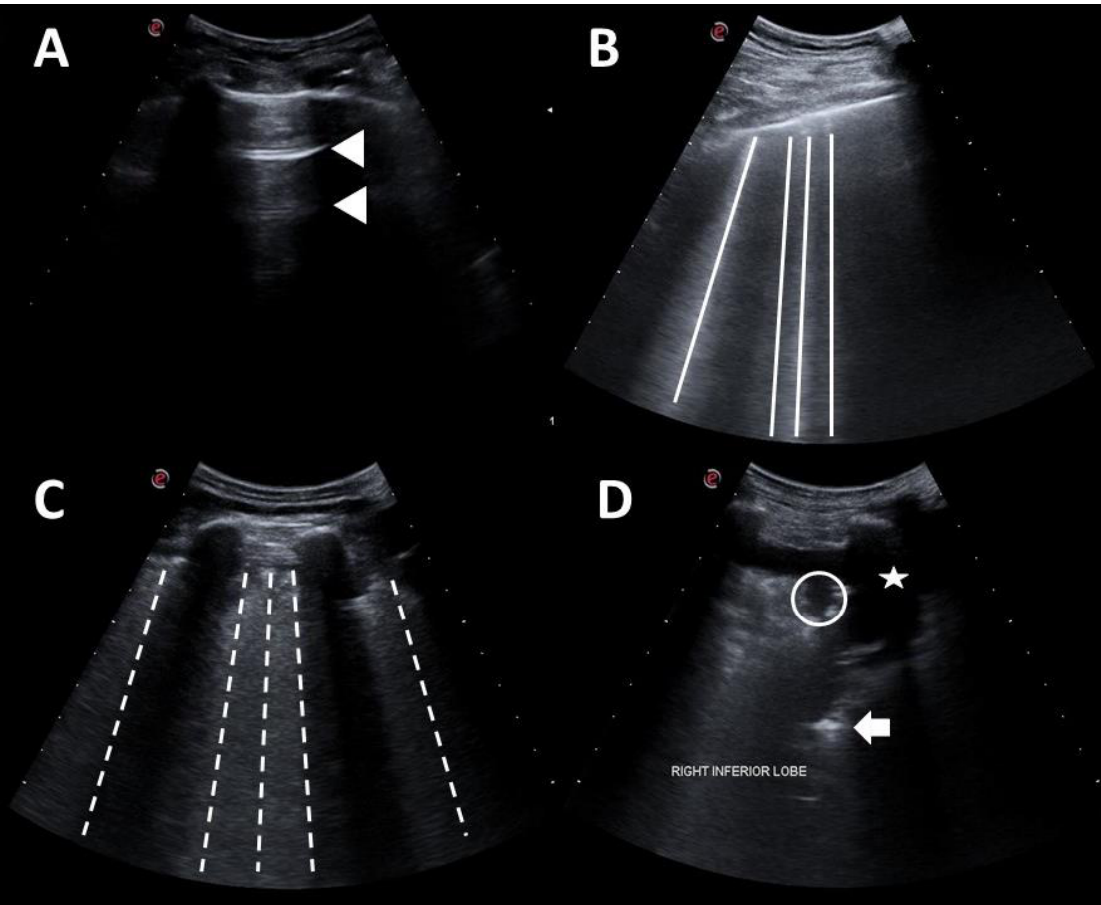
Figure 2. Lung ultrasonography grading score is part of BLUE protocol for evaluation of dyspnoea in emergency setting. ( A ) Score 0: normal pattern, A-lines or <3 B-lines; ( B ) score 1: moderate loss, ≥ 3 B-lines; ( C ) score 2: severe loss, coalescent B-lines; ( D ) score 3: complete loss, white lung and/or lung consolidations. Legend: pleural line is indicated by star; A-lines are indicated by triangles; B-lines are indicated by continue lines; coalescent B-lines are indicated by dashed lines; Consolidation is indicated by circles, aerial bronchogram is indicated by arrow, while pleural effusion is indicated by stars.